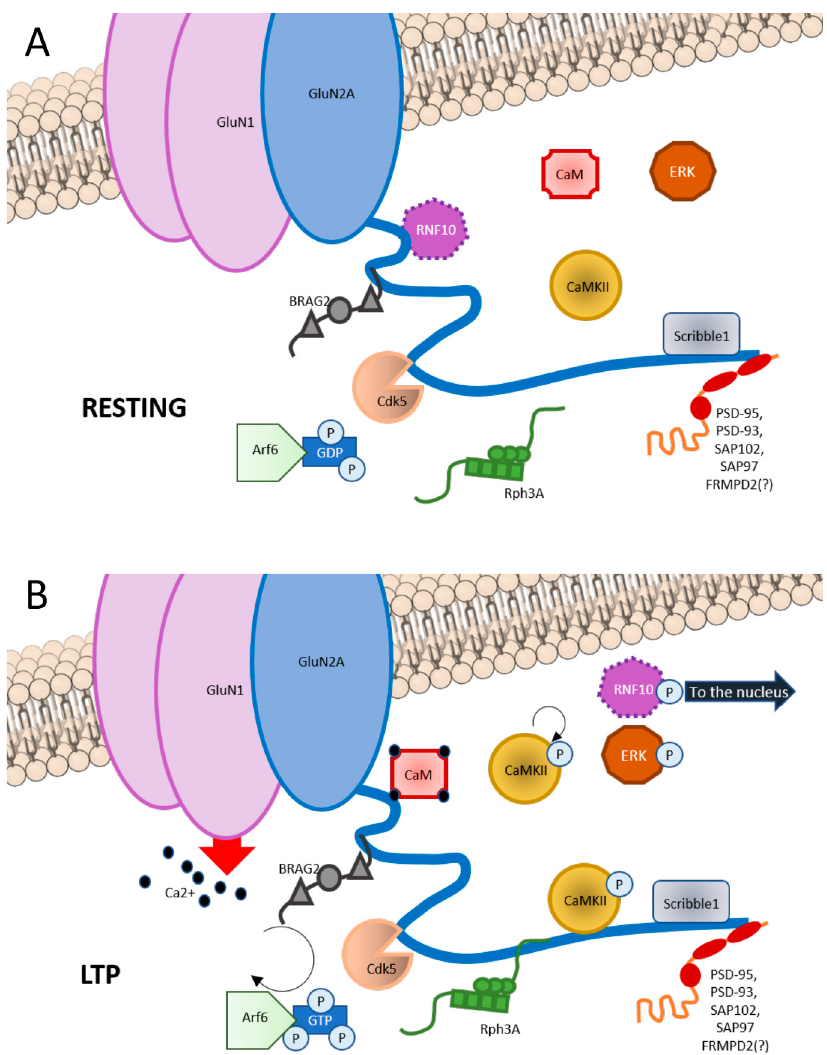
Figure 1. Graphic representation of GluN2A interactors at C-terminal domain (CTD). ( A ) In basal condition, GluN2A CTD binds RNF10 at aa991-1049; BRAG2 at aa1078-1117; Cdk5 at aa1218-1246; CaMKII at aa1389-1464; Scribble1 at 1458-1464; and PSD sca ff olding proteins such as PSD-93, PSD-95, SAP102, and SAP97 at aa1461-1464. ( B ) Upon LTP induction, phosphorylation of RNF10 triggers RNF10 detachment and its nuclear translocation. Simultaneously, CaM binds to aa875-1029 of GluN2A. BRAG2 exchanges GDP with GTP to Arf6-GTPase, which is involved is vesicles recycle at the postsynapse, also with Scribble1. Rph3A interaction with GluN2A at aa1349-1389 increases. CaMKII is disinhibited and is recruited at the postsynapse. Ras-ERK downstream cascade is